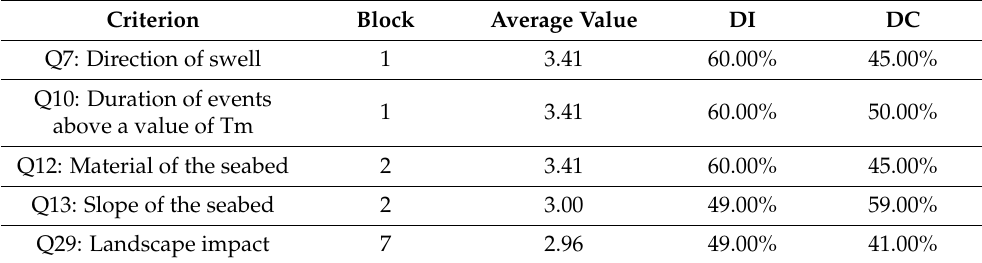
Table 12. Criteria meeting DI ≤ 60% and DC ≤ 60%